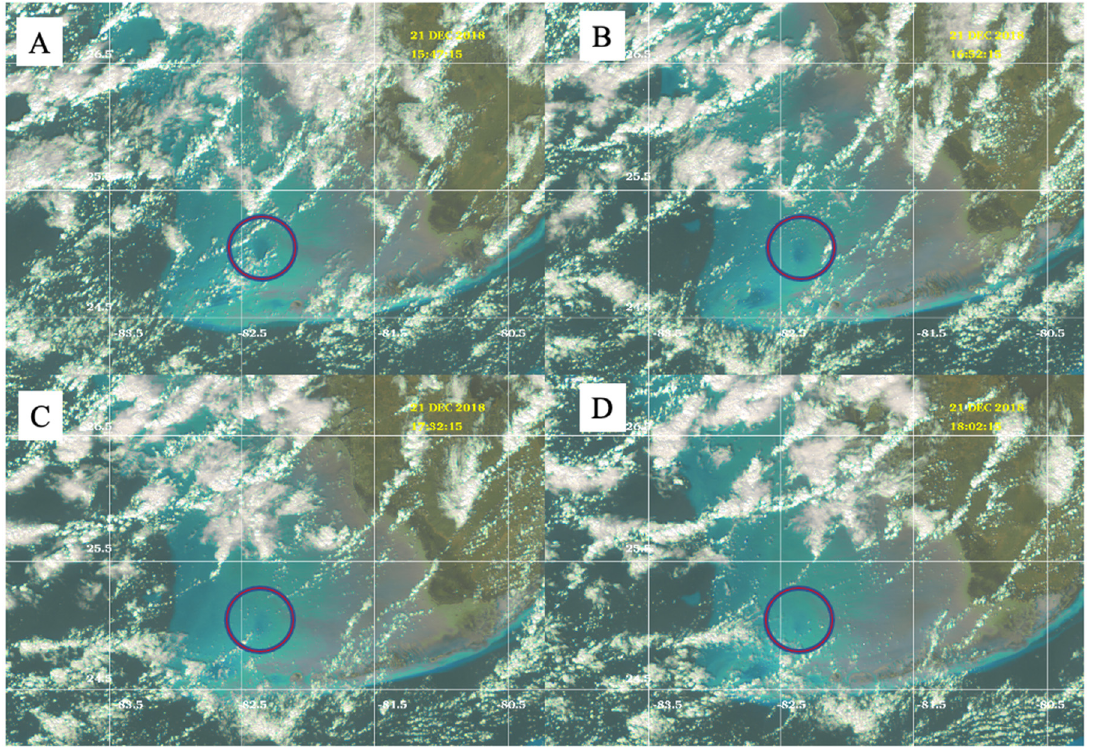
Figure 11. Color-enhanced GOES-R Advanced Baseline Imager (ABI) images on 21 December ( A ) 1542 ( B ) 1652 ( C ) 1732 and ( D ) 1802 UTC.